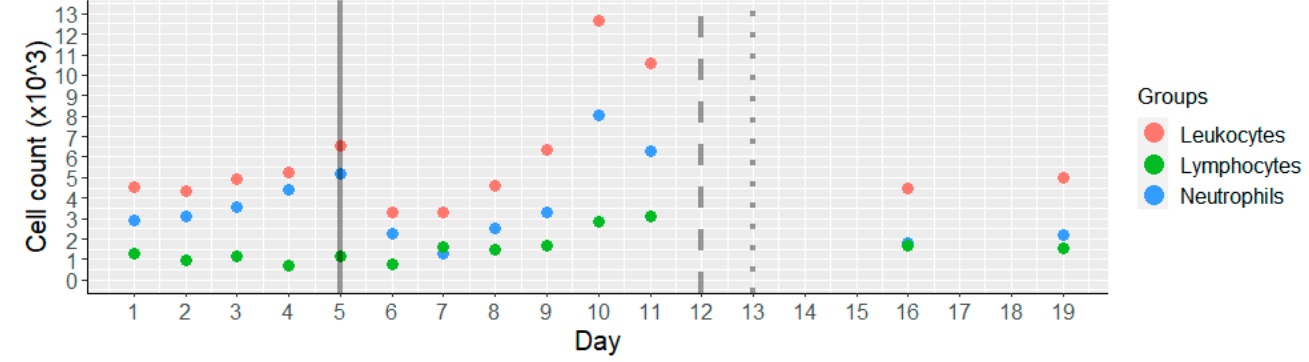
Figure 4. Leukocyte, lymphocyte, and neutrophil Counts ( × 10 3 ) throughout the hospitalization period. The solid line denotes transfer to PICU + intubation, the dashed line denotes extubation, and the dotted line denotes discharge from PICU.